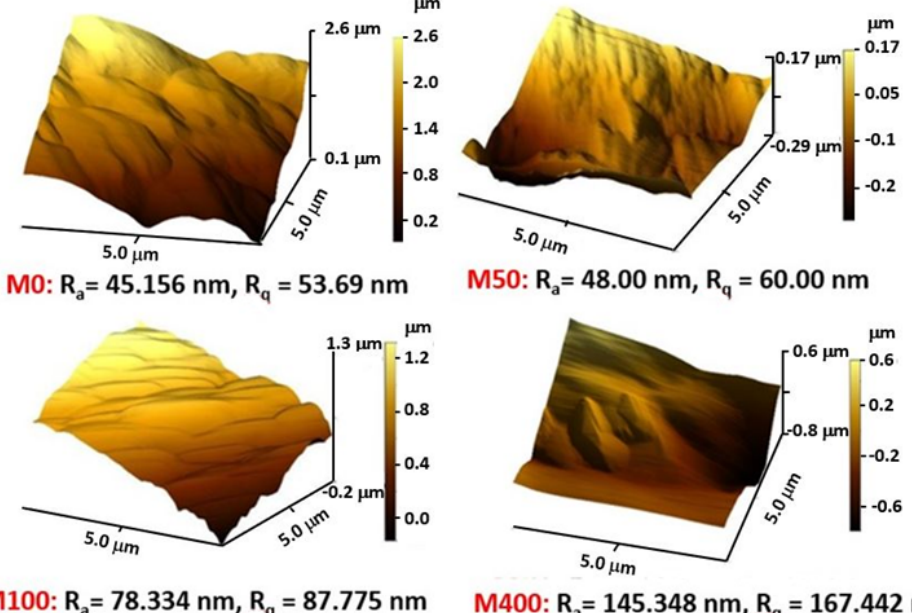
Figure 2. Atomic Force Microscopy (AFM) images of chitosan/PEG/CNT/BKC nanocomposite membrane. Mechanical properties of the composite membranes were examined in tensile